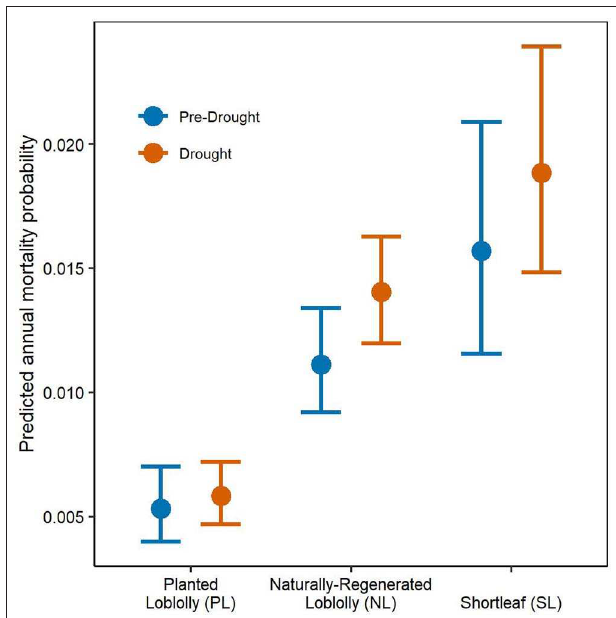
FIGURE 2 | Mortality probabilities for each pine group and measurement period with 95% credible intervals. Pre-drought period trees were measured and re-measured from 2003 to 2010 while drought period trees were initially measured prior to 2011 and re-measured 2012–2016. The R 2 for the mixed predictive assessment was 0.09. Prediction accuracy of live and dead trees was 0.999 and 0.132 for observed vs. predicted responses and 0.916 and 0.097 for replicated vs. predicted responses,